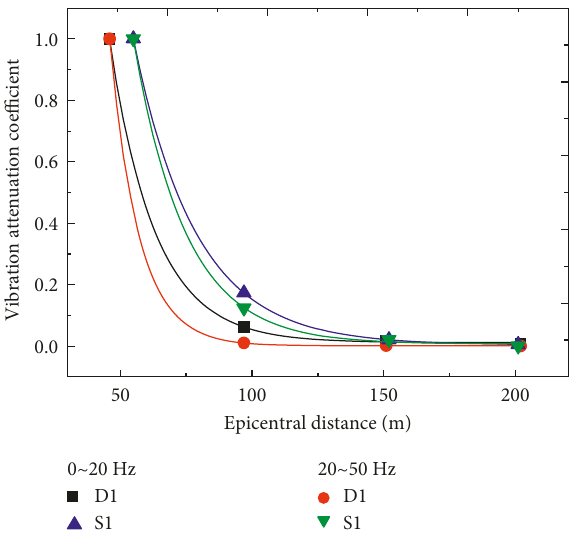
Figure 10: The energy attenuation law of different frequency